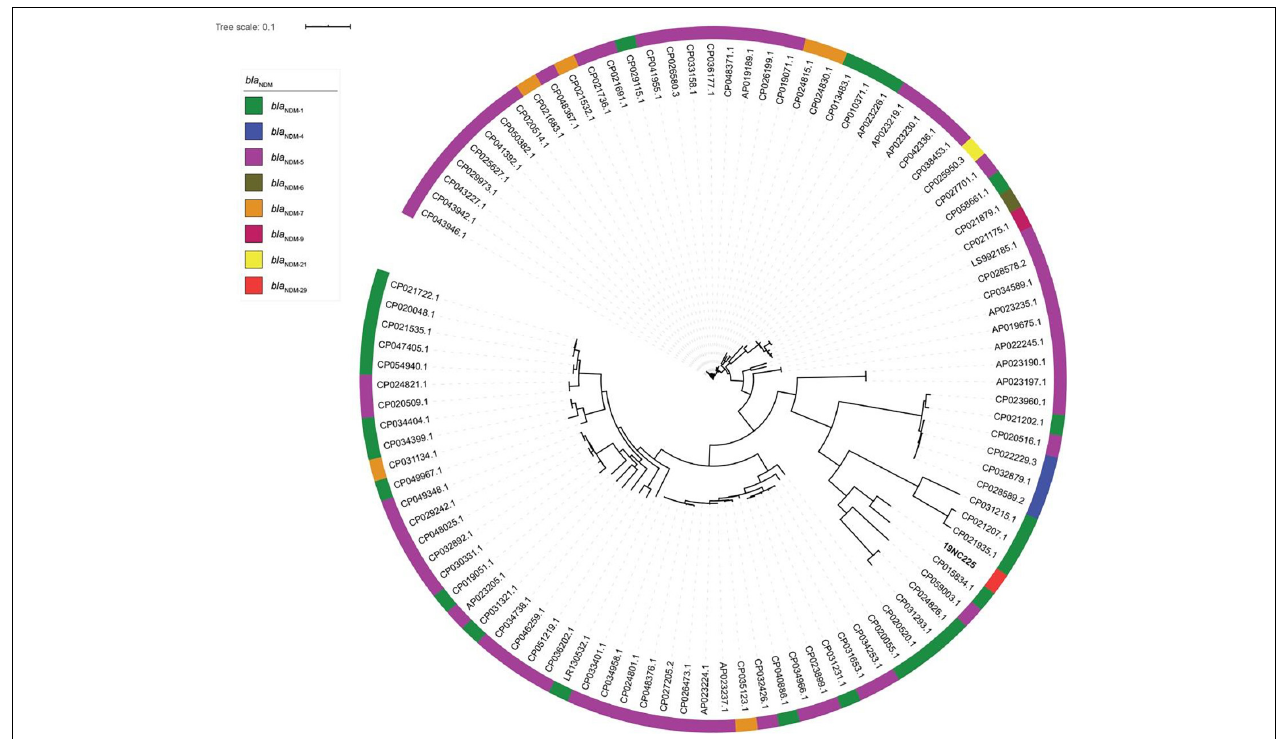
FIGURE 3 | Phylogenic tree of E. coli strains with complete genomes containing bla NDM variants. The colored strips on the outside ring indicate the eight bla NDM variants.